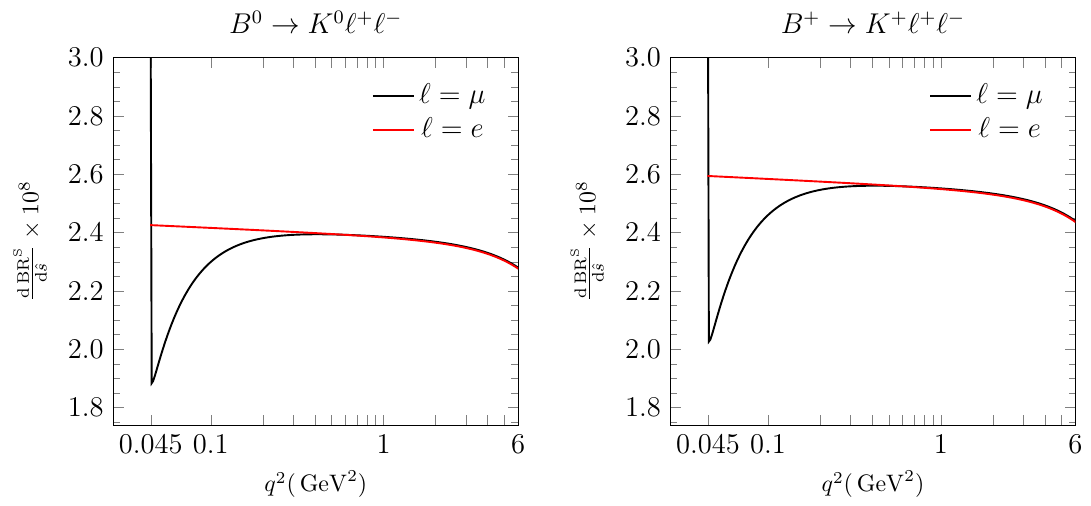
Figure 7 . Di(cid:11)erential distributions of branching ratios for the pure Sommerfeld correction, as a function of q 2 . Left and right plots correspond to the neutral B 0 ! K 0 and charged B + ! K + transitions respectively.